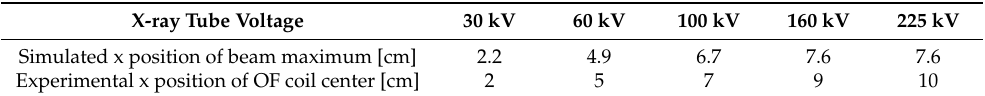
Table 1. Simulated x position of the X-ray beam maximum, and location of the irradiated OF sample, according to operating voltage.